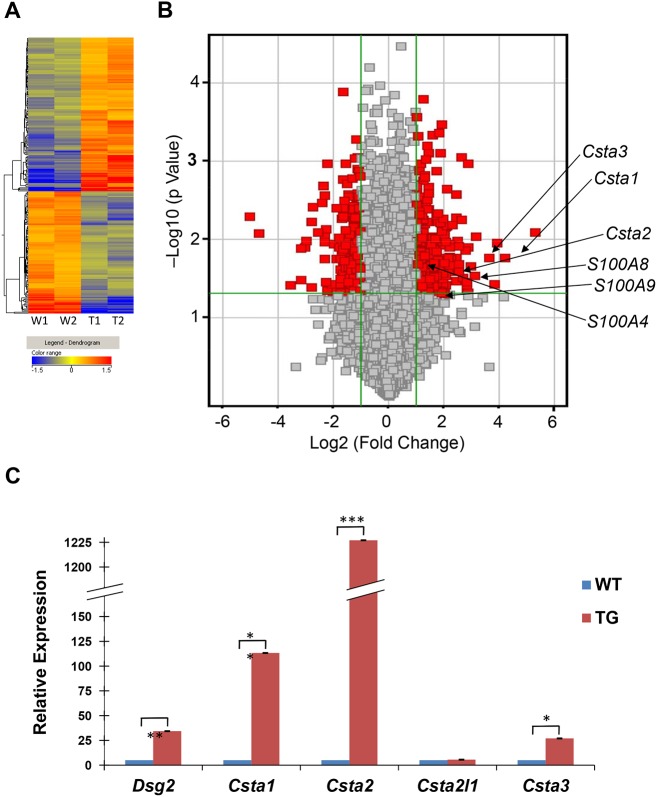
Differential gene expression between Inv-Dsg2 transgenic and wild-type mouse skin.(A) Total RNA was isolated from the skin of 2 wild-type and 2 Inv-Dsg2 transgenic mice, reverse transcribed, biotin-labeled and applied to a mouse cDNA microarray. The dendogram (heat map) shows that 492 genes were either up-regulated (red/orange) or down-regulated (blue/green) in transgenic (T1 and T2) and control (W1 and W2) mice. (B) Volcano plot shows the log2 (fold change) in x-axis versus the—log10 (p value) in the y-axis. The points having a fold-change less than 2 (log2 = 1) are shown in gray. The vertical green lines demarcate where the fold change equals 2 (right line) or equals—2 (left line). The horizontal green line demarcates where the p value is 0.05, with points above the line having p<0.05 and points below the line having p>0.05. Depicted in red are the genes that exhibit a greater than 2 fold change with a p>0.05 in transgenic epidermis as compared to control. The arrows indicate genes of interest. (C) Quantitative real-time RT-PCR analysis reveals an average of 34.33±1.32 fold increase in Dsg2 RNA expression in Inv-Dsg2 transgenic (Tg) compared to that of wild-type (WT). In addition, RNA expression for transgenic relative to control were: Csta1, 113.24 ±2.23; Csta2, 1227.04 ±1.26; Csta2l1, 1.11 ±0.47; Csta3, 26.97±0.44 (Bar = mean ± s.d.; (*p< 0.05; **p<0.01; ***p<0.001; Student’s t test).